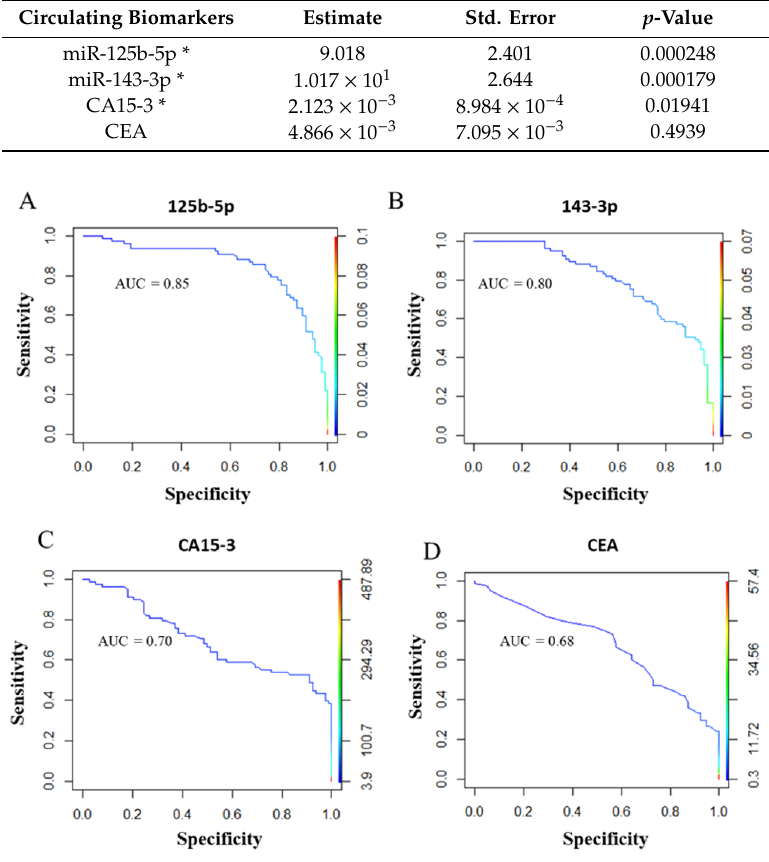
Figure 3. ROC curve analyses and AUC values of miR-125-5p ( A ), miR-143-3p ( B ), CA15-3 ( C ), and CEA ( D ) for discriminating BC patients from healthy controls in 76 BC patients and 78 healthy donors. ROC: Receiver operating characteristic; AUC: area under the ROC curve; CEA: carcinoembryonic